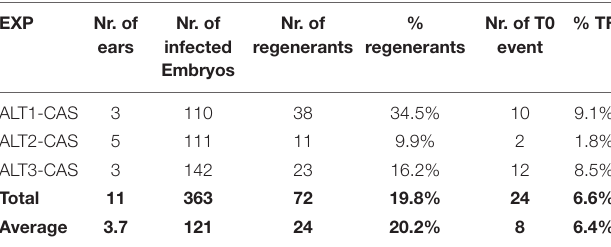
TABLE 3 | Summary of transformation frequency (TF) of three